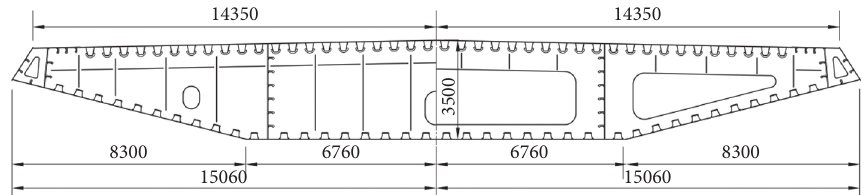
Figure 2: Cross-section of the steel box girder (unit: m).